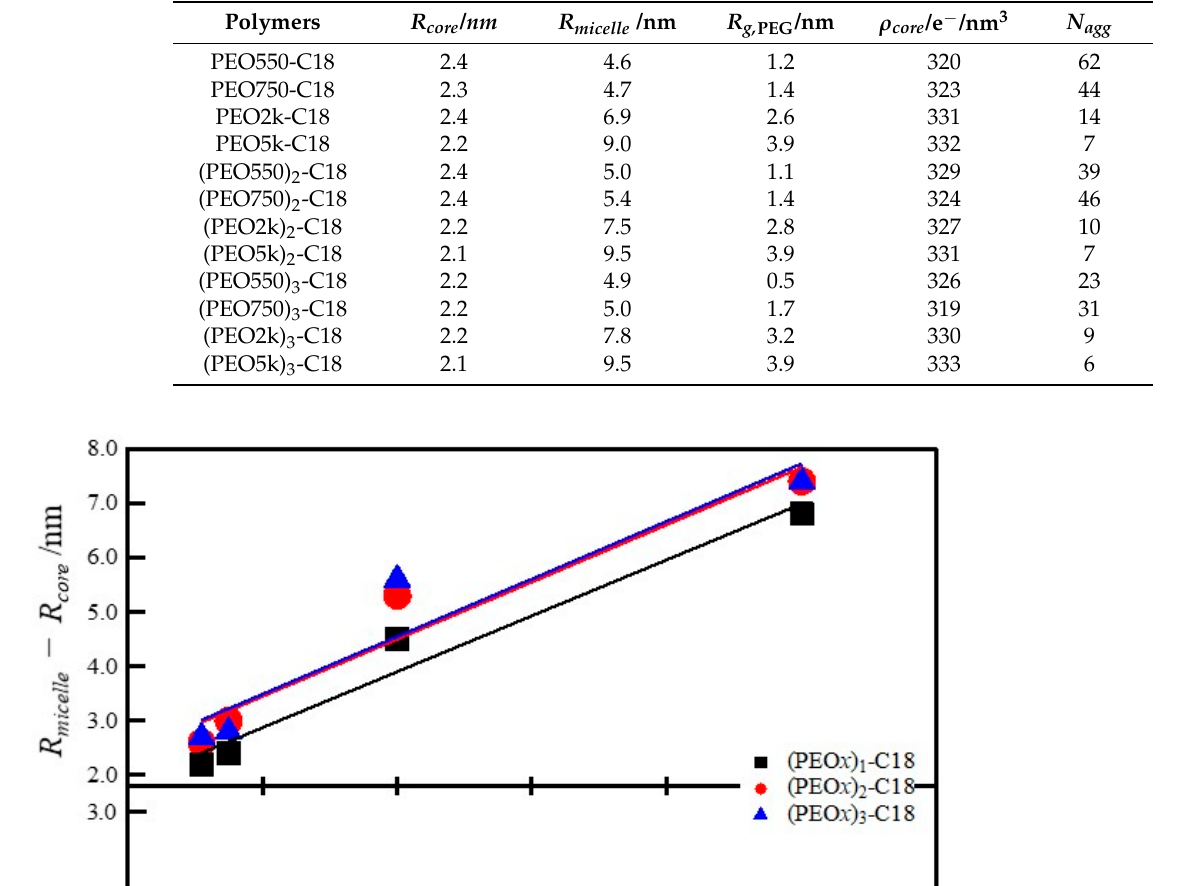
Table 2. Characteristics of (PEO x ) y -C18 micelles obtained from SAXS analyses.